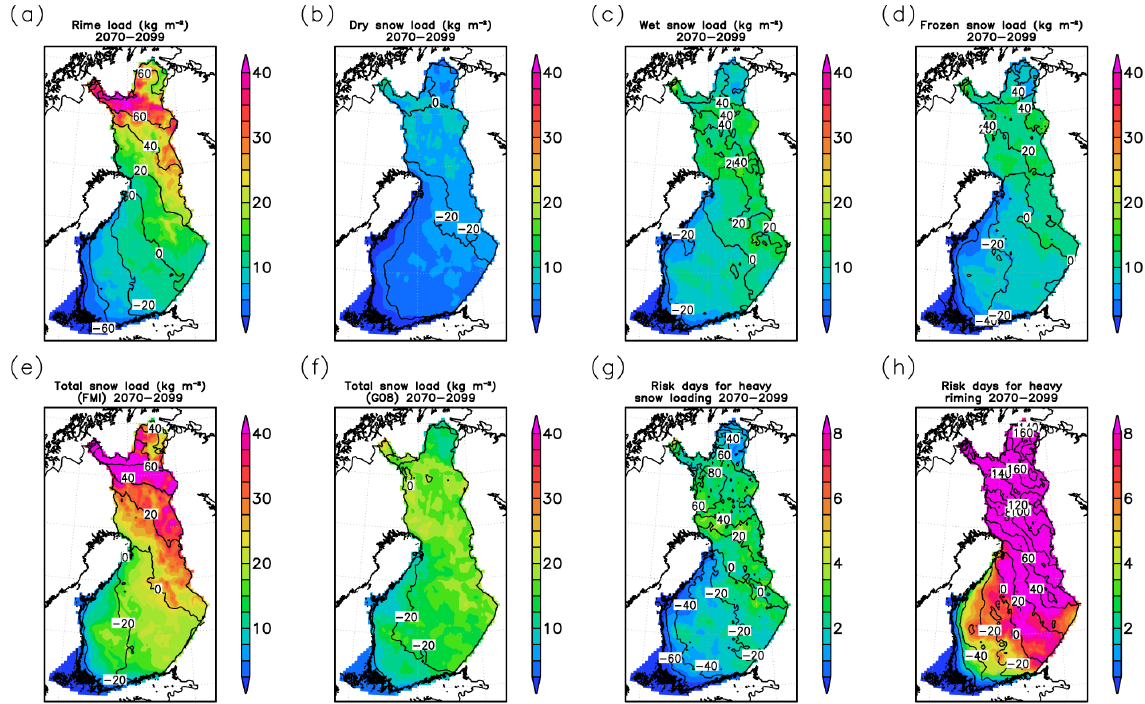
Figure 5. The annual maximum rime loads (a) , dry snow loads (b) , wet snow loads (c) , frozen snow loads (d) , total snow loads based on the FMI method (e) and total snow loads based on the G08 method (f) for the period 2070–2099 under the RCP8.5 scenario as a multi-model mean. Contours show the multi-model mean change from 1980–2009 to 2070–2099.